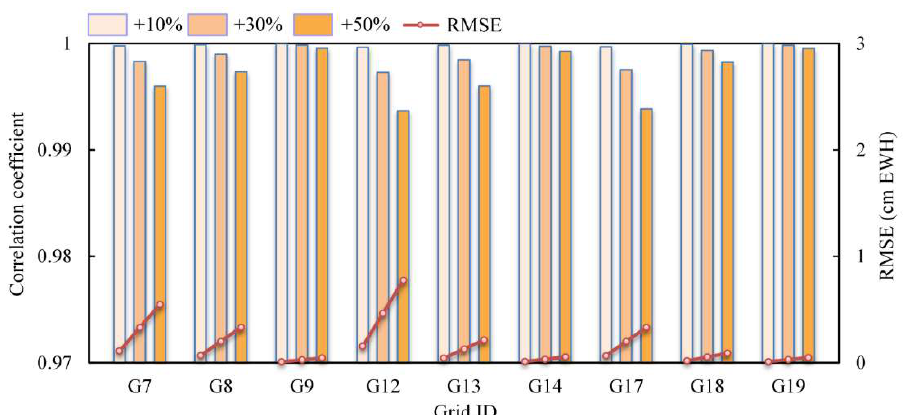
Figure 5. Influence of changing model boundary conditions on model simulation results.